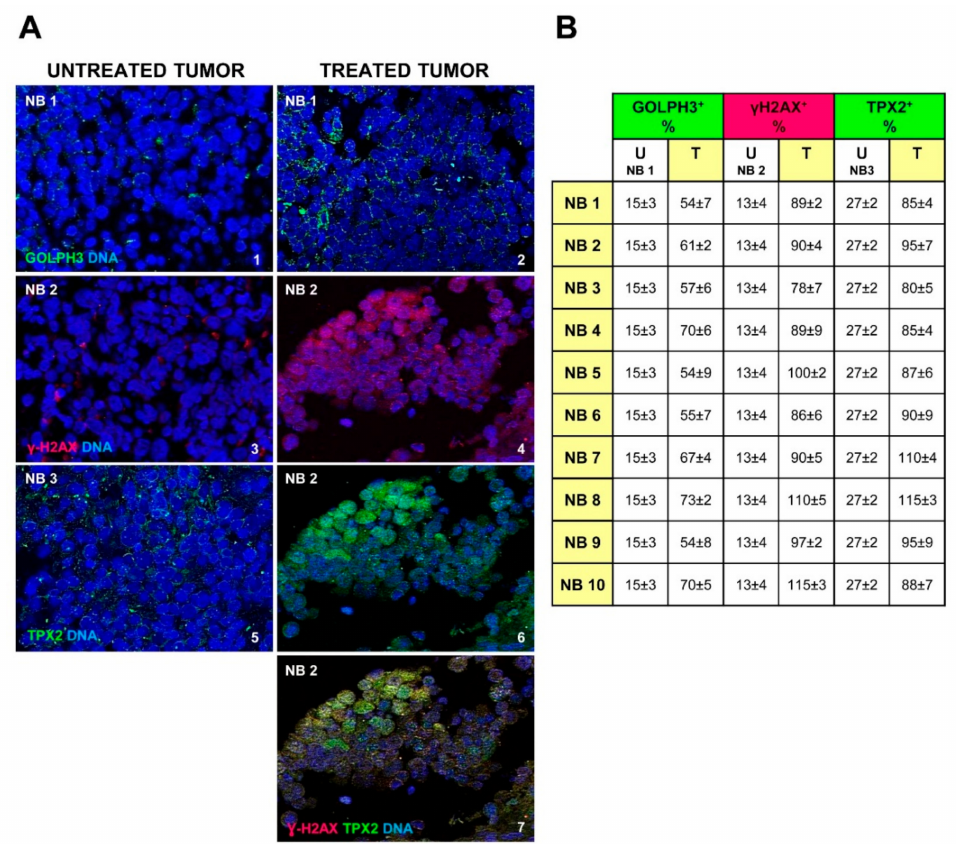
Figure 5. Golgi dispersal, DNA damage and expression of TPX2 oncogene are effects of chemotherapy in neuroblastoma (NB) patients. ( A ) Representative images of immunofluorescence analysis of NB tumor samples before (NB1, NB2, NB3) (1,3,5) and after chemotherapy (NB1, NB2) (2,4,6), by anti-GOLPH3 antibody (green) (1,2), anti- γ H2AX antibody (red) (3,4) and anti-TPX2 antibody (green) (5,6). Image 7 comes from image 4 merged with image 6, to show the co-localized expression of the two proteins. Cells nuclei are counterstained with DAPI (blue). (Magnification 40 × ). ( B ) In the table are reported the percentages of GOLPH3, γ H2AX and TPX2 positive cells observed in the 10 NB chemotherapy treated samples (NB1 to NB10), compared to a not treated NB specimen (NB1, NB2 and NB3) (U = untreated tumor; T = chemotherapy treated tumor). Data are representative of three independent observations ±